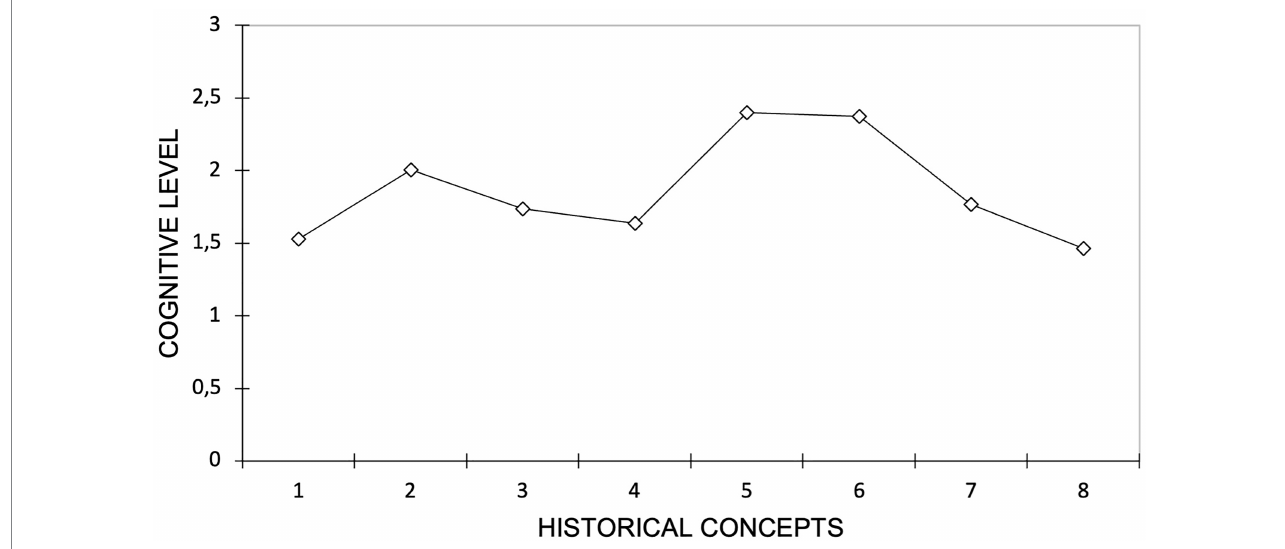
FIGURE 4 Relationship of first and second-order historical concepts with the cognitive level required in the textbook activities (2nd year secondary